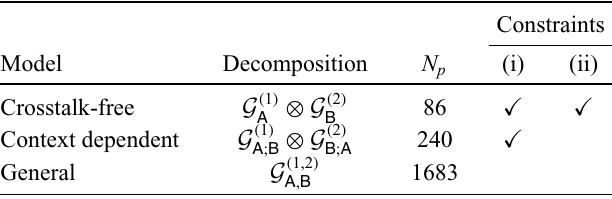
TABLE I. Three nested families of process matrix models for quantum logic operations. Each successively larger model can capture richer forms of crosstalk between qubits than the pre- vious ones. Also shown are the decompositions of the process matrices as tensor products of local operations when operations A and B are applied simultaneously to subsystems 1 and 2, respec- tively. Here N p is the number of free parameters required to describe the model.